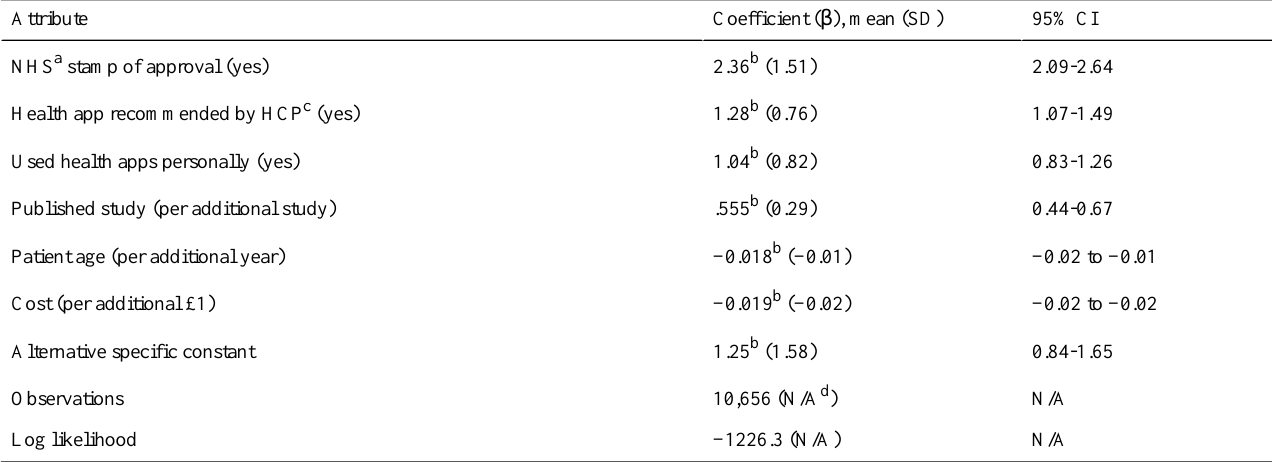
Table 3. Preferences for digital health technologies as reported by health care